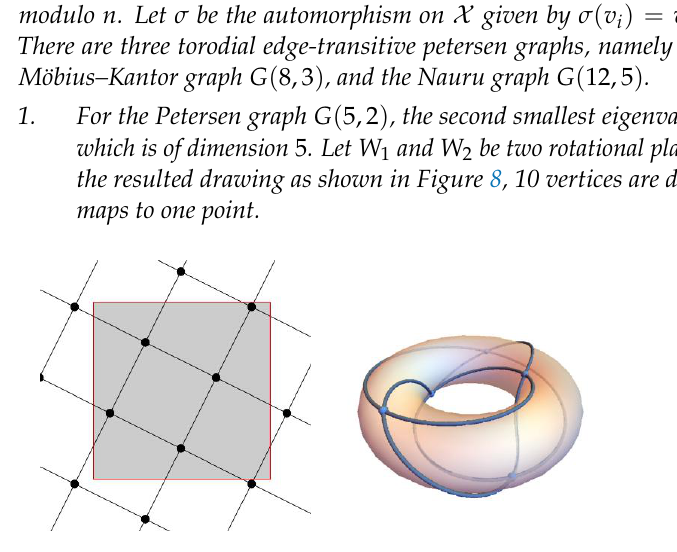
Figure 8. The (ramified) drawings of the Petersen graph G ( 5,2 )